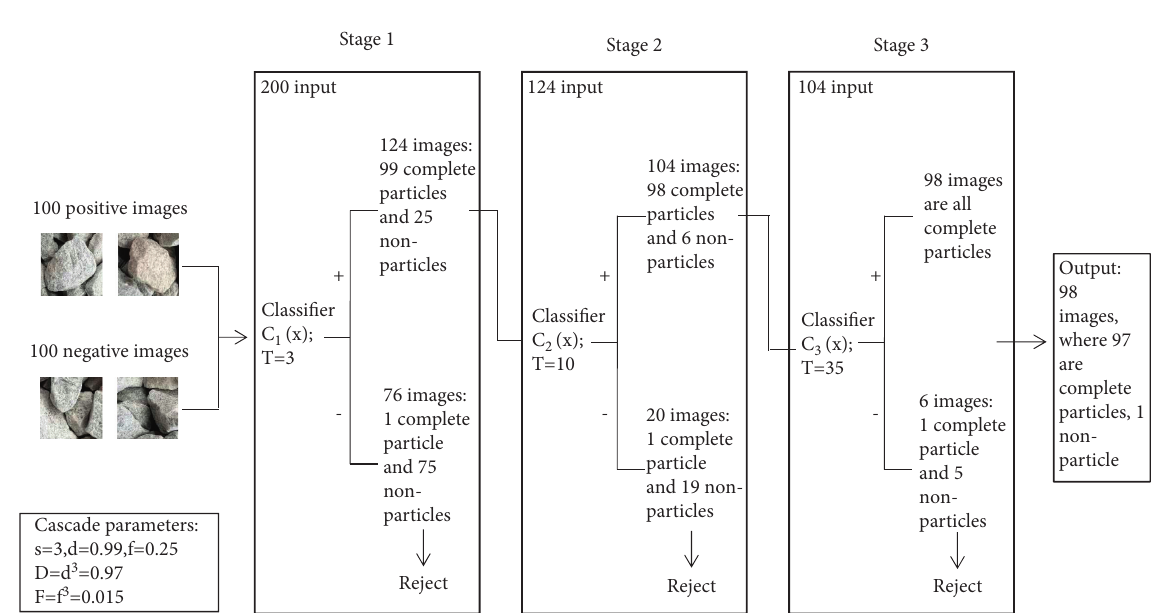
Figure 7: A hypothetical example of the Cascade